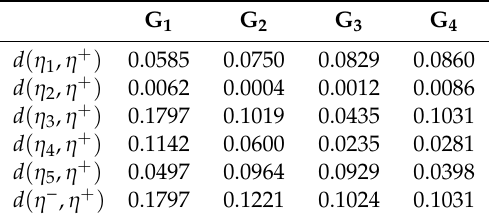
Table 4. The results of combination distance.